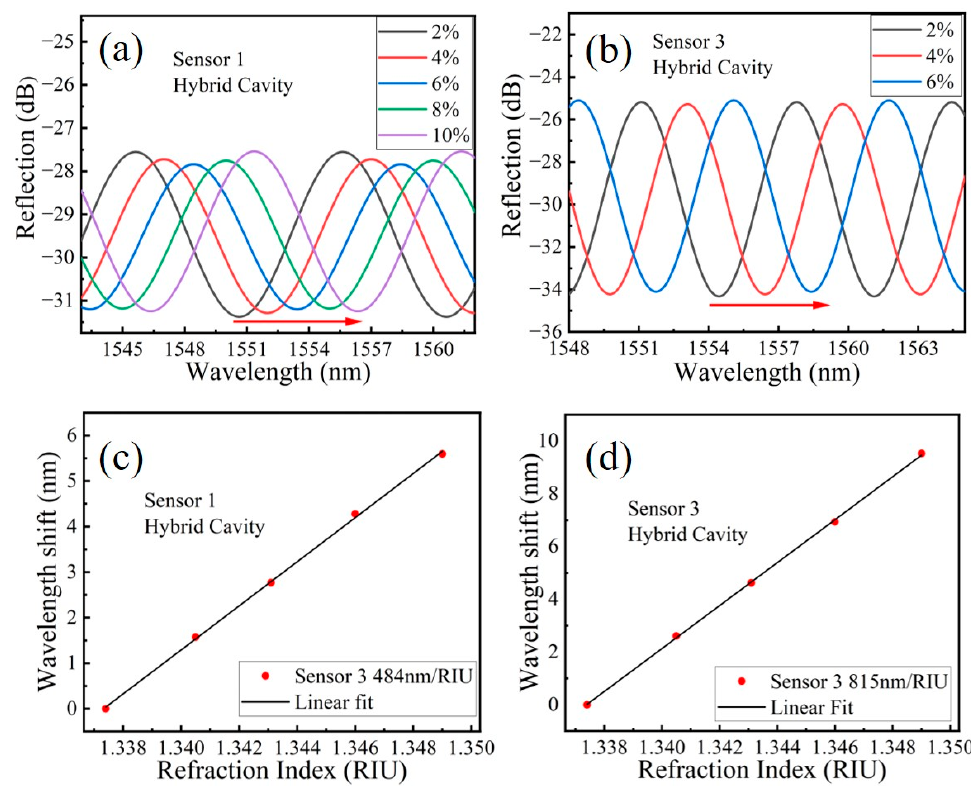
Figure 6. ( a , b ) The extracted interference spectrums of the hybrid cavity of S1 and S3, respectively; ( c , d ) The resonant wavelength drift with di ff erent RI of S1 and S3,